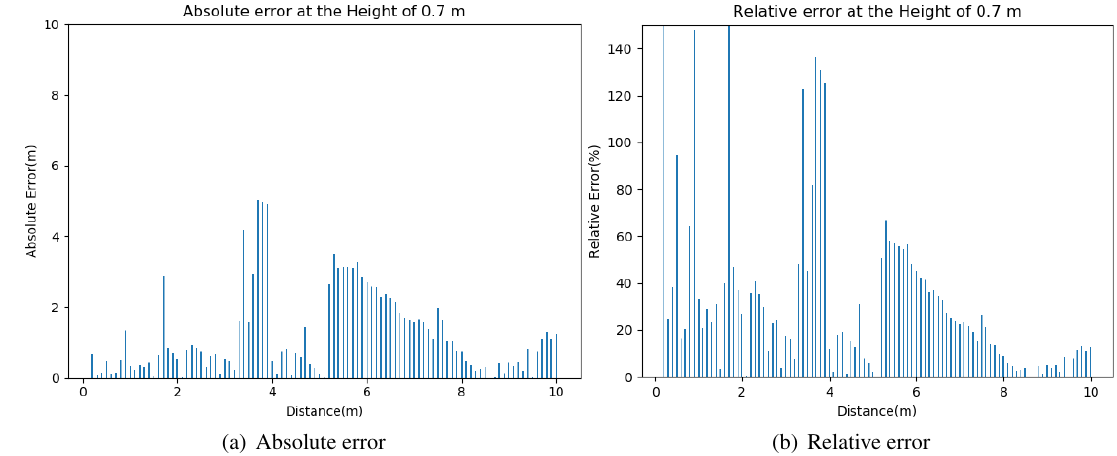
Fig. 4 Errors after supervised